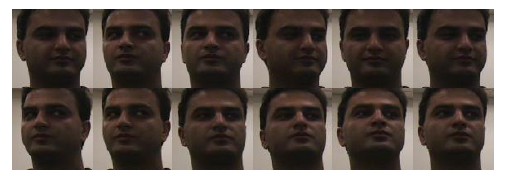
Figure 2. Face area marked by distance between two eyes.